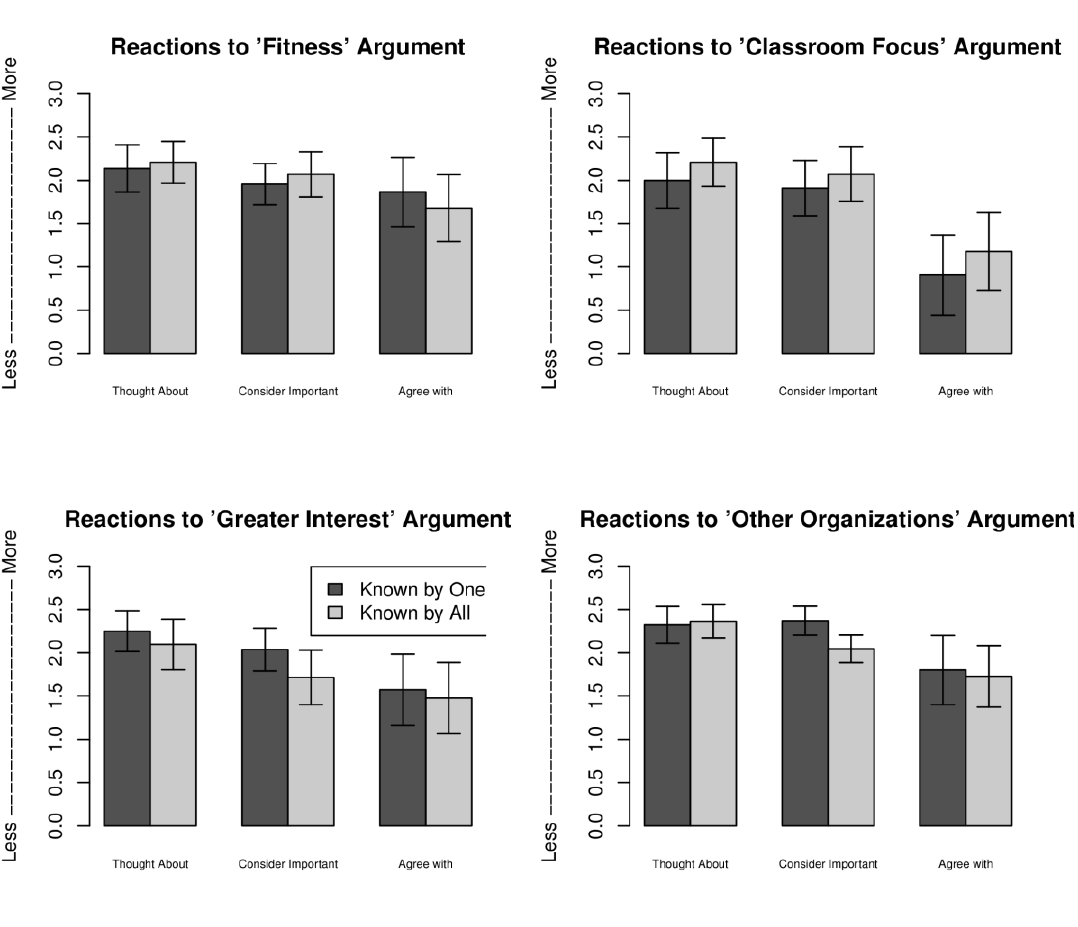
Figure 3: Post-Discussion Reactions to Individual